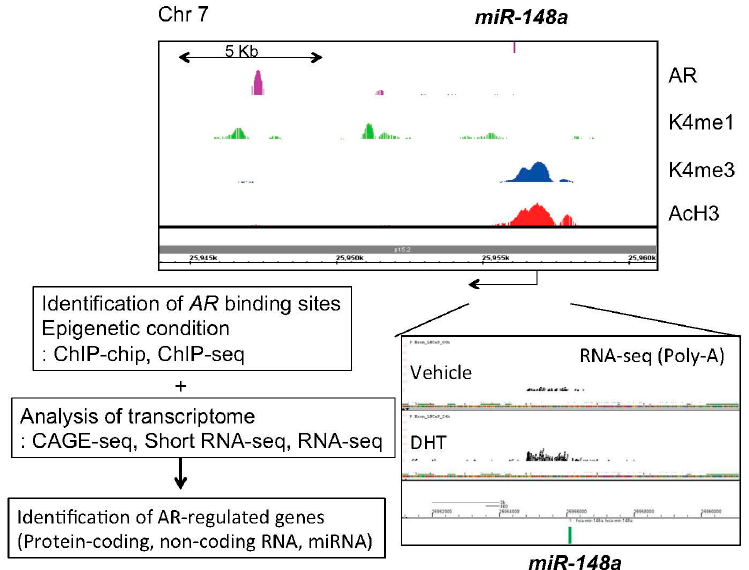
Figure 1. Investigation of AR-mediated miRNA regulation by integrating epigenetic and transcriptomic approaches. We performed CAGE, RNA-seq, short RNA-seq and ChIP-seq to reveal comprehensive epigenetic status, androgen-regulated transcripts and AR binding sites. CAGE; Cap analysis of gene expression, K4me1 or 3; Histone H3 lysine (K) 4 mono or tri-methylation,